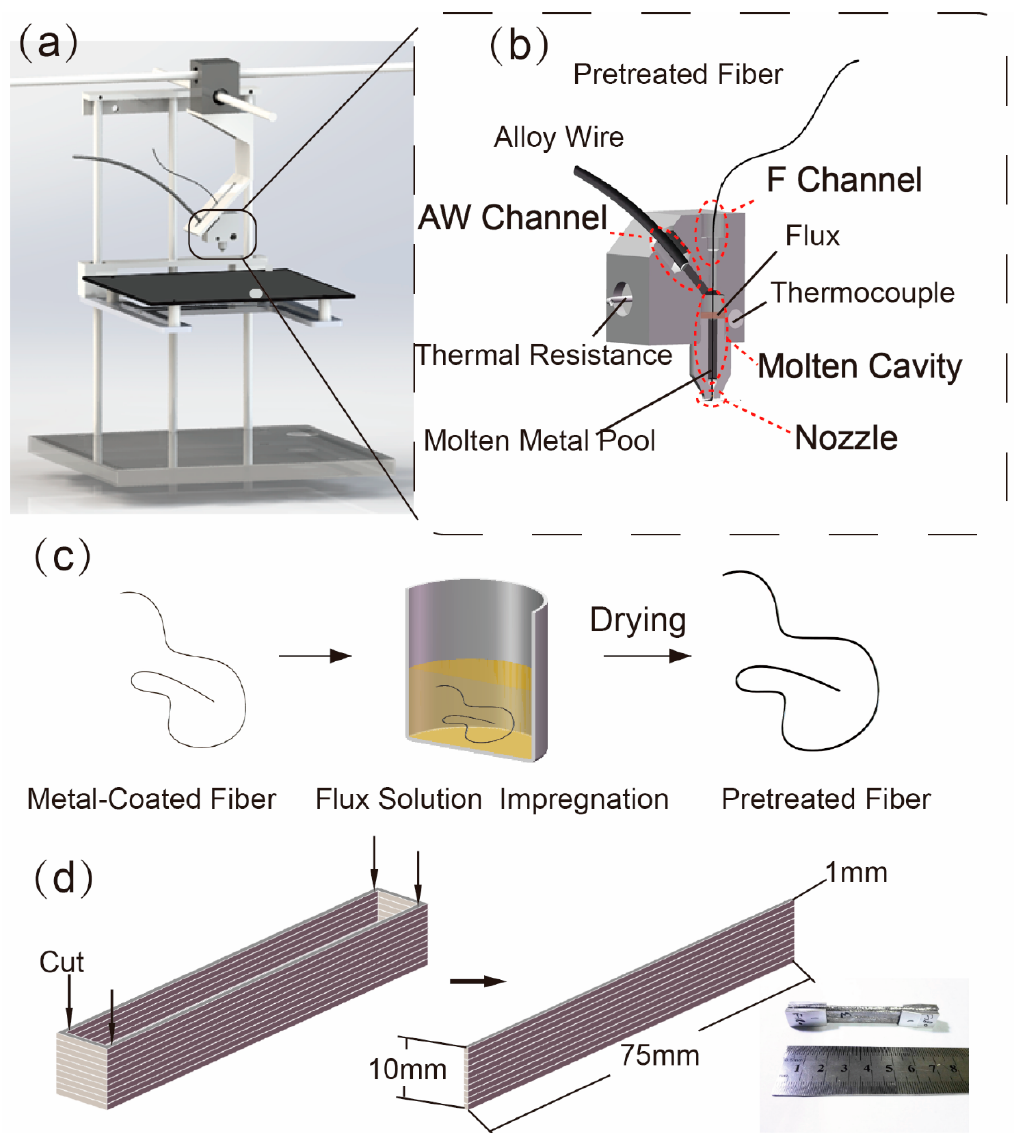
Figure 1. Schematic illustration of the continuous fiber reinforced metal matrix composites (CFRMMCs) fabrication process. ( a ) Structure of 3D printer of CFRMMCs; ( b ) sectional view of the printing head; ( c ) process of fiber pretreatment; ( d ) design of tensile specimen and the printed specimen.